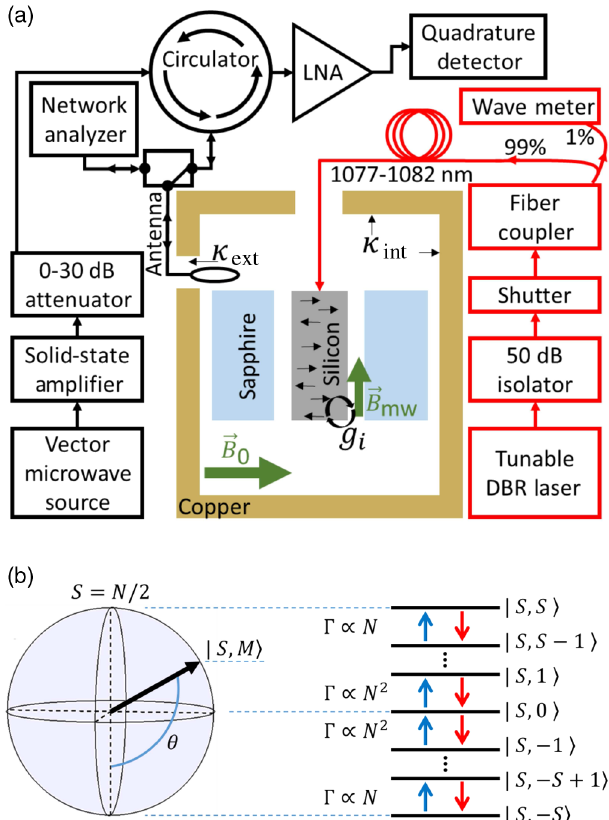
FIG. 1. (a) Experimental scheme for delivering microwave and optical excitation to the phosphorus donor spin ensemble ( ˆ s , i ¼ 1 ; … ; N ↑ þ N ↓ ) positioned inside a cylindrical dielectric i (sapphire) microwave cavity within a helium cryostat ( T ¼ 1 . 5 K). The spins are placed in a ∼ 3500 -G dc magnetic ⃗ B field ( 0 ) and coupled magnetically to the cylindrical TE011 ⃗ B ) with individual cavity mode (microwave magnetic field, mw spin-cavity coupling g ( i ¼ 1 ; … ; N ↑ þ N ↓ ). Current losses in i ) and coupling losses ( κ ) through the the copper walls ( κ int ext antenna along with dephasing in the spin ensemble ( γ ¼ 1 =T (cid:2) 2 ) set the maximum window during which the spin-cavity dynamics can be probed. (b) In the case of small inhomogeneous broad- ¼ ω ) and uniform cavity coupling ( g ¼ g ), the spin ening ( ω i i ensemble can be modeled as a single large pseudospin as shown in the Bloch sphere representation. The sphere surface represents the symmetric superradiant subspace ( j S; M i ). Strong correla- tions between spins in these states lead to an enhanced photon emission rate Γ ∝ N 2 near the equator ( M ¼ 0 ). Uncorrelated spontaneous emission at a rate Γ ∝ N dominates near the poles ( M ¼ (cid:3) S